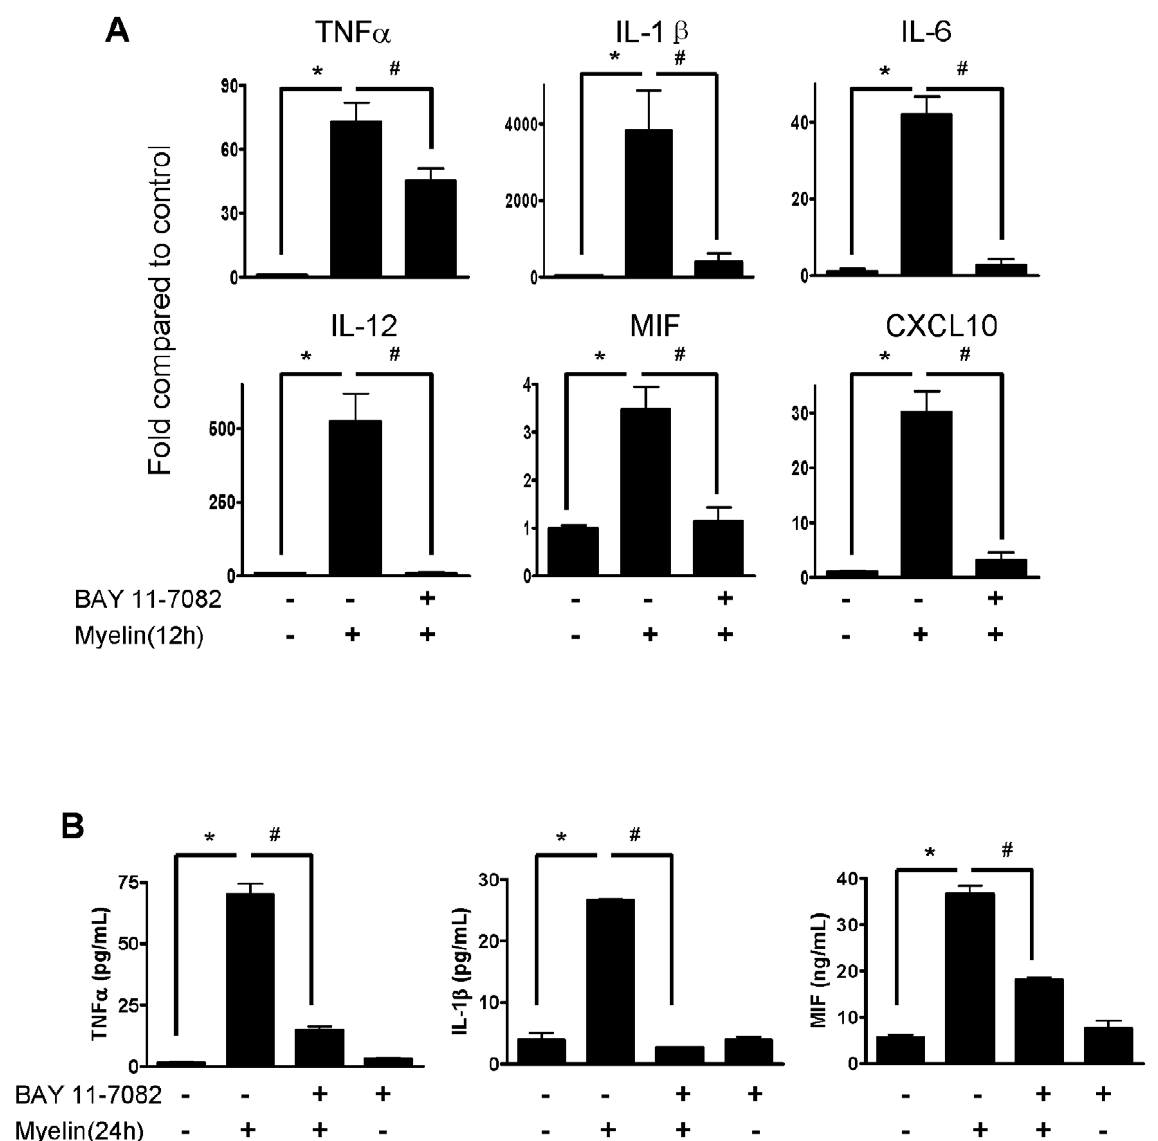
Figure 5. Effect of inactivation of NF- k B on myelin-induced cytokine expression in macrophages. (A) Macrophages were pre-treated with BAY 11-7082 for 30 minutes and then treated with myelin for 12 hours. Cytokines at transcriptional level were detected by qRT-PCR.